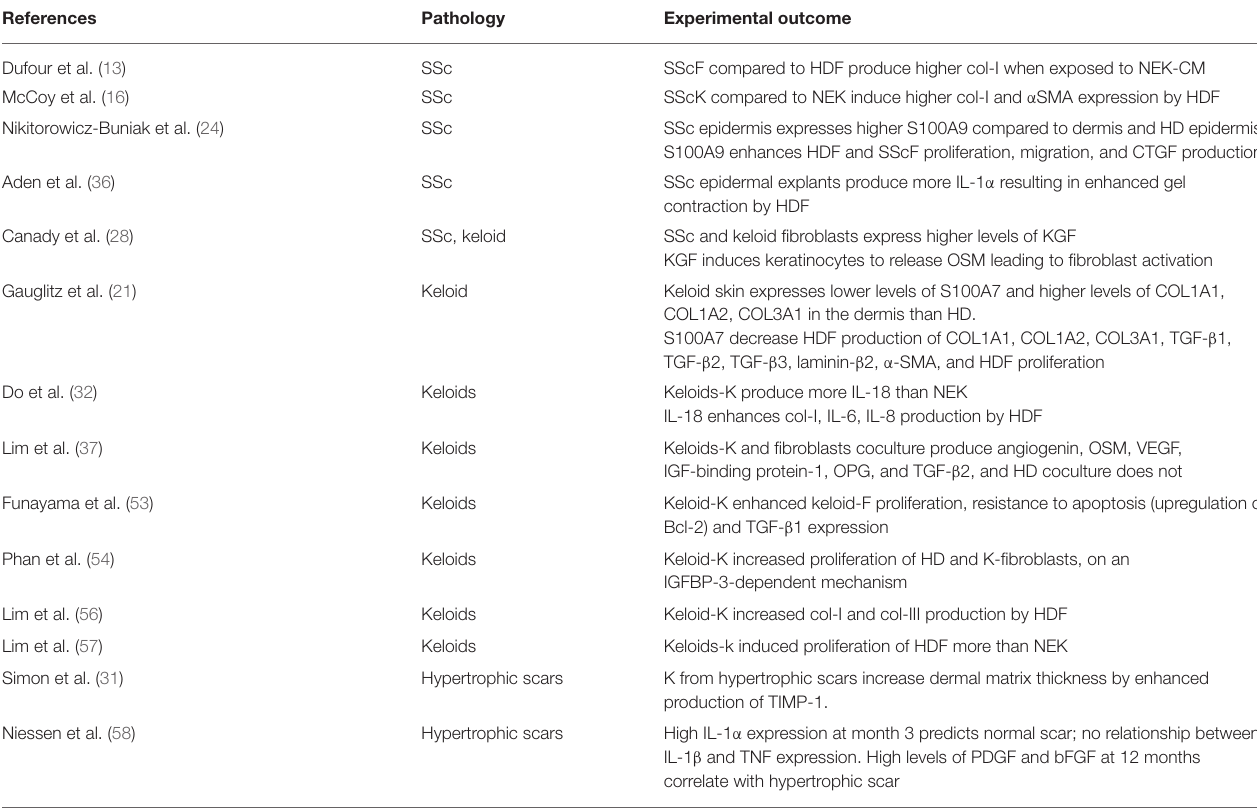
TABLE 3 | Keratinocyte–fibroblast crosstalk in fibrotic